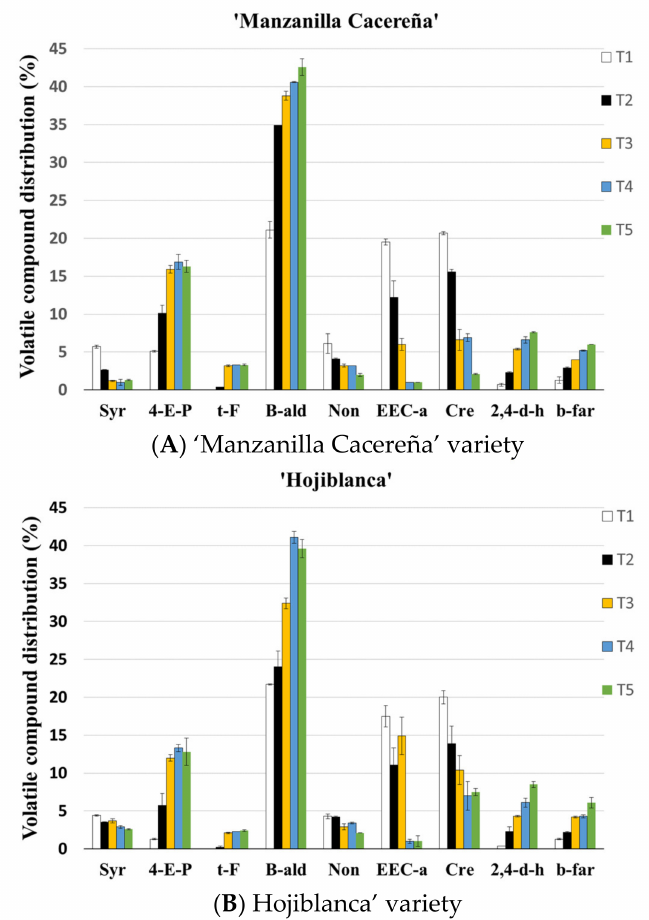
Figure 2. Relative contents of volatile compounds (mean% ( n = 4)) obtained from Californian-style black olives from “Manzanilla Cacereña”( A ) and “Hojiblanca”( B ) varieties and submitted to five different sterilization treatments: T1: F0 = 10 min; T2: F0 = 14 min; T3 F0 = 18 min; T4: F0 = 22 min; and T5: F0 = 26 min. Syr: styrene; 4-E-P: 4-ethenyl-pyridine; t-F: trans-farnesol; B-ald: benzaldehyde; Non: nonanal; EEC-a: ethyl ester cyclohexanecarboxylic acid; Cre: creosol; 2,4-d-h: 2,4-dimethyl- hexane; b-far: